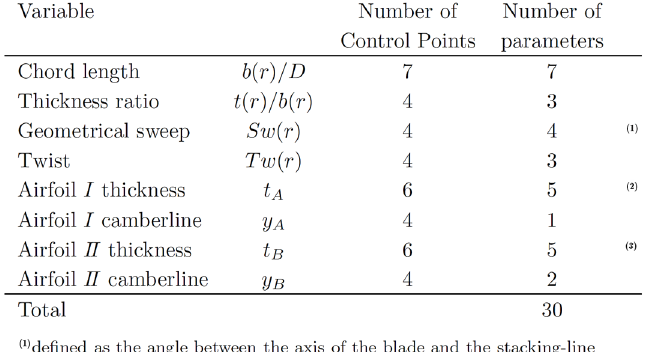
7 of 18 Figure 5. Comparison between reference blade (dashed line), and optimized blade (solid line) [31]. Reprinted with permission from Pagano, A. (2010). Similar work was done by Marinus et al. [32] in which they utilized a Multi-Objective Differential Evolution (MODE) technique coupled with a genetic algorithm to optimize propeller blades for transonic flow. By allowing the algorithm to vary geometric variables